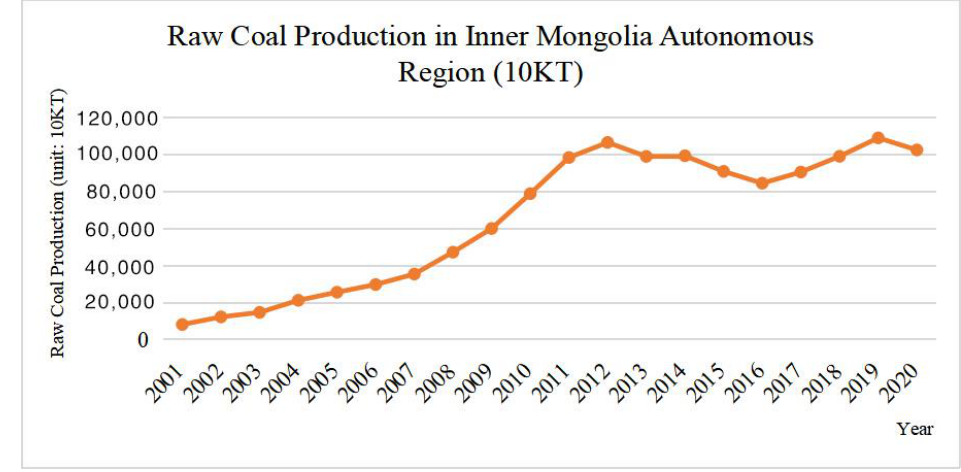
Figure 3. 2001 – 2020 Raw coal production in Inner Mongolia Autonomous Region. Figure 3. 2001–2020 Raw coal production in Inner Mongolia Autonomous Region.